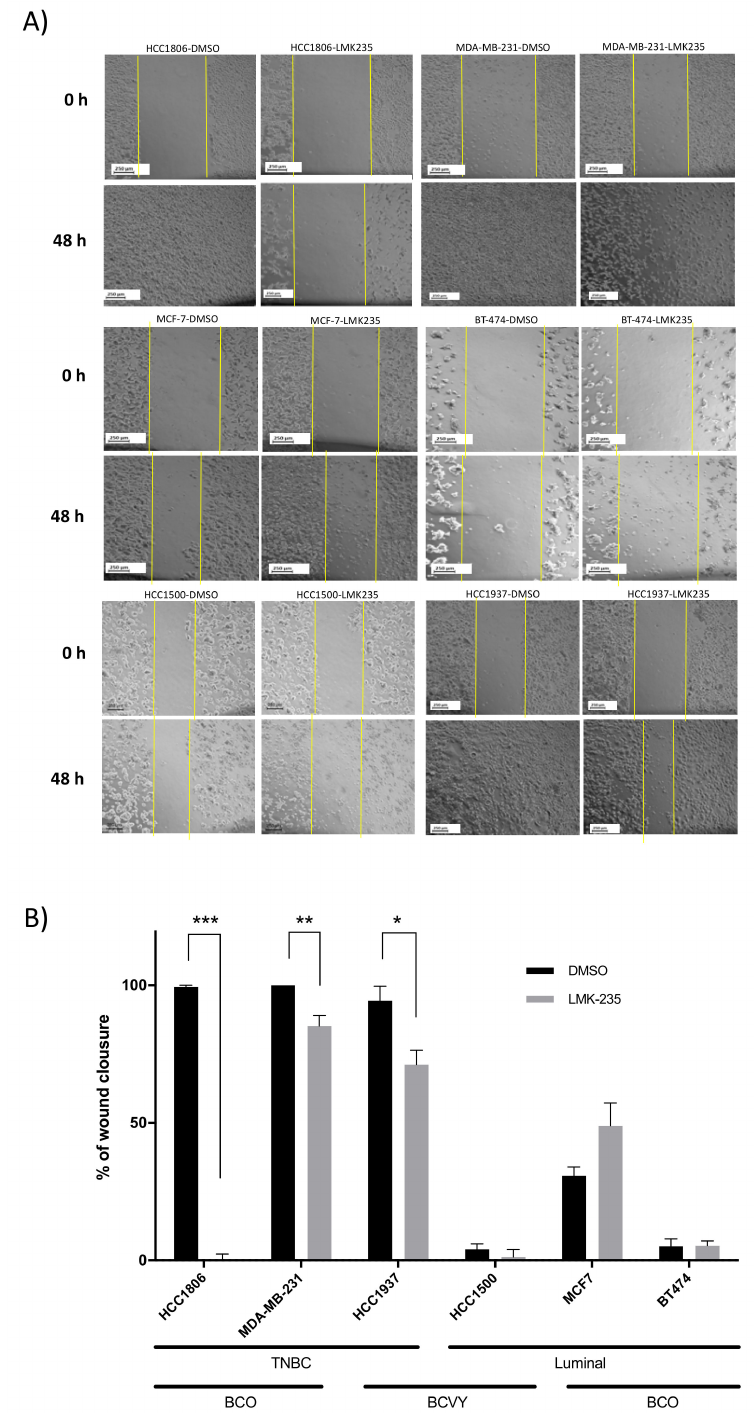
Figure 4. E ff ects of LMK-235 treatments in BC cell migration. Cell migration was assessed by scratch wound-healing assay after treatment with LMK-235 (20 µ M) for 48 h. Images of cell migration at 0 h and 48 h after LMK-235 (20 µ M) treatment ( A ); Percentage of wound closure after 48 h of LMK-235 (20 µ M) treatment or DMSO / control. Three separate experiments were conducted, and representative results are shown ( B ). Columns mean ± SD of the percentage of wound closure in the three independent experiments. Black bars represent control DMSO cells and grey bars represent cells treated with LMK-235. * p ≤ 0.05, ** p ≤ 0.01, *** p ≤ 0.001 statistically significant. TNBC: Triple negative breast cancer; BCVY: breast cancer in very young women; BCO: Breast cancer in old